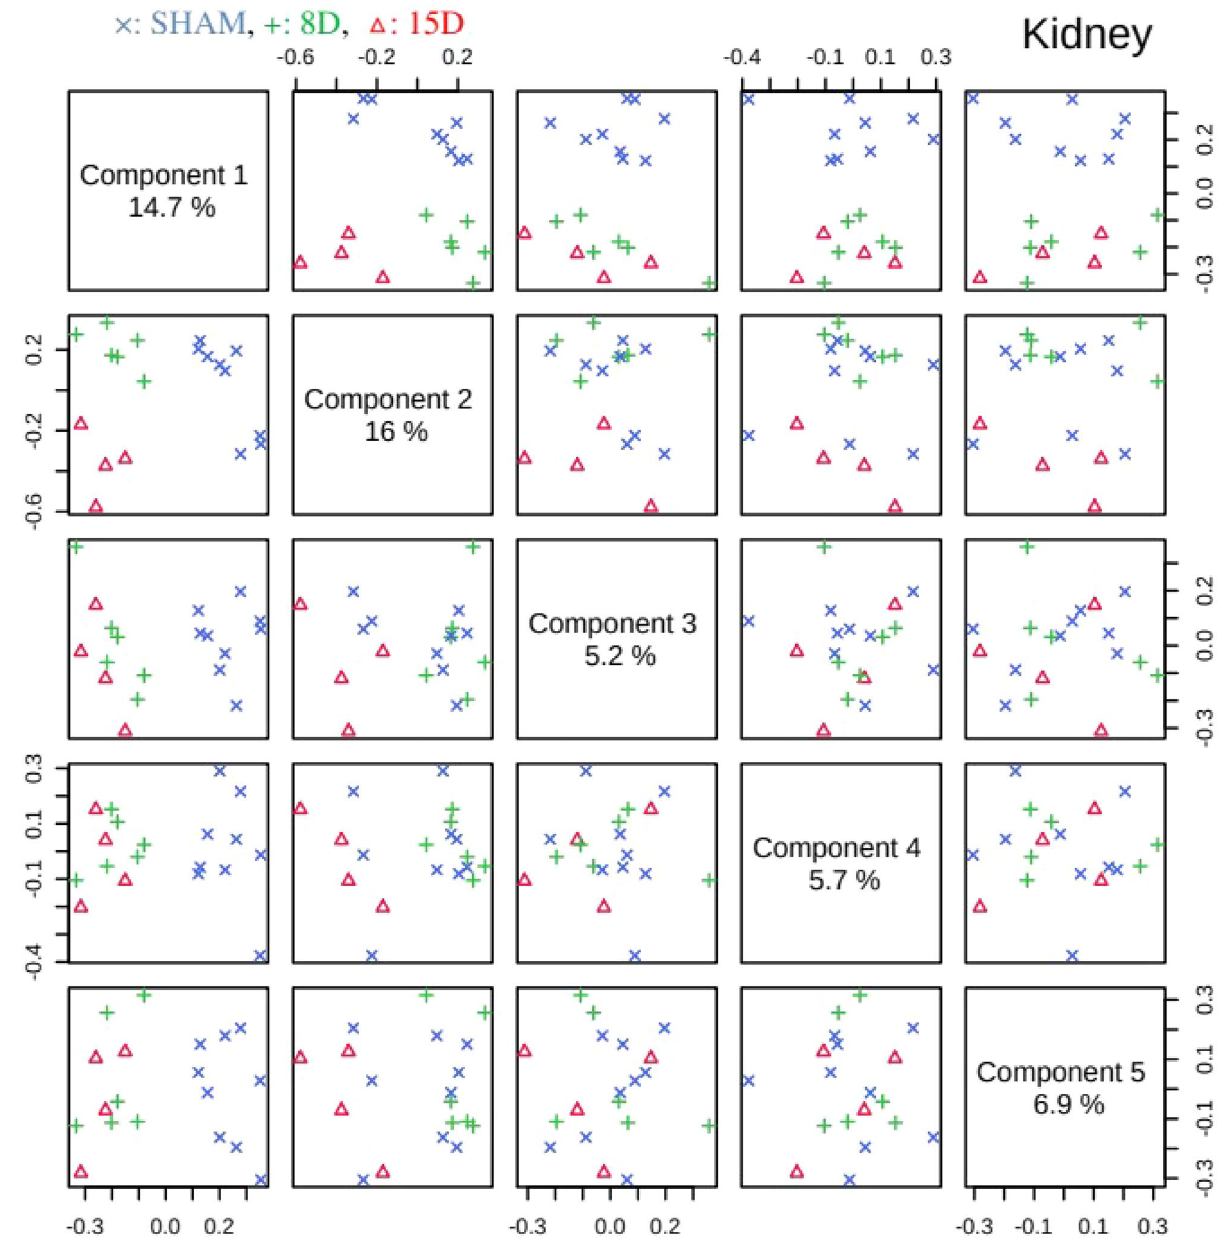
Figure 4. Pairwise score plots between the selected PLS-DA components for kidney group. The explained variance of each component is shown in the corresponding diagonal cell. (x: SHAM, + : 8D, (cid:31) :